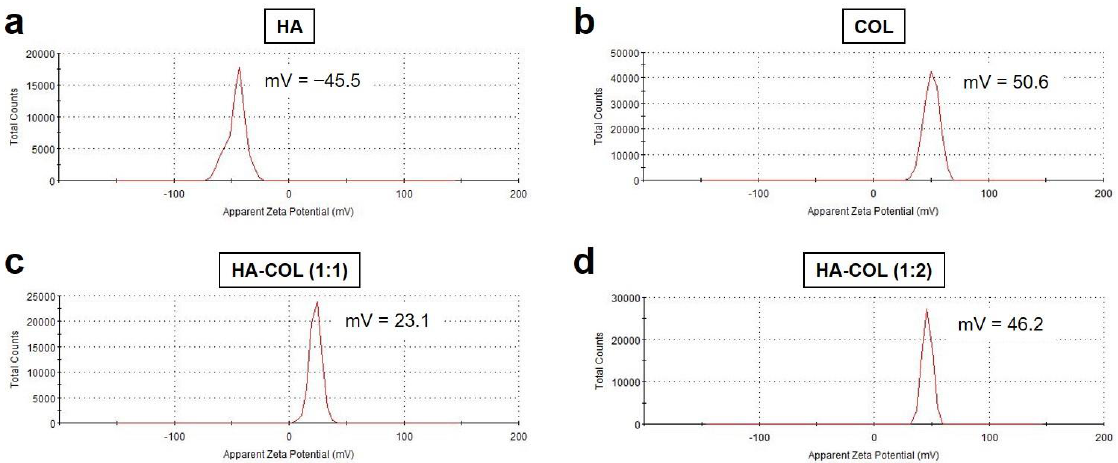
Figure 4. Zeta potential of ( a ) LMW-HA, ( b ) COL, ( c ) HA-COL (1:1), and ( d ) HA-COL (1:2) before and after formation of nanocomplexes. The HA-COL nanocomplexes were prepared at varying mo- lar ratios from 1:1 to 1:2